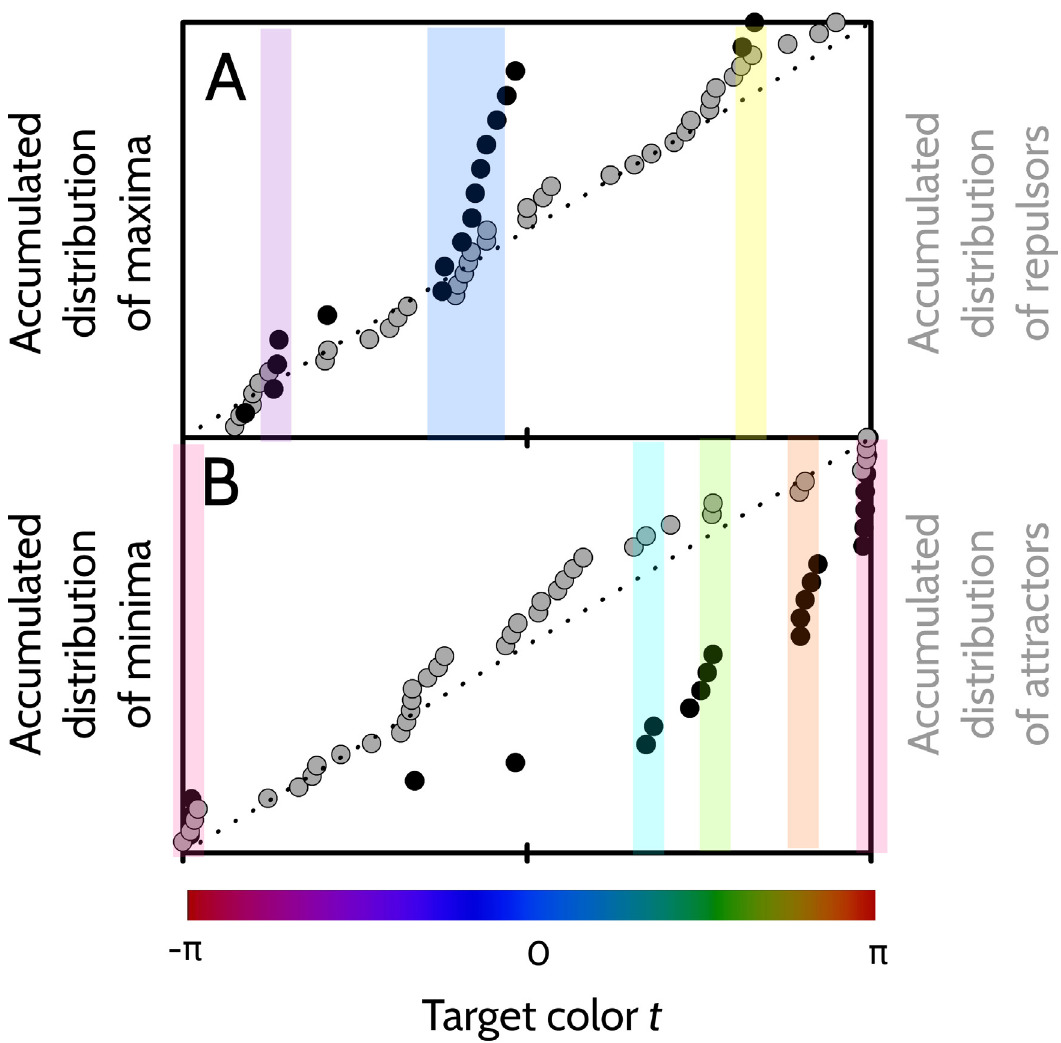
Fig 9. Relation between attractors, repulsors and Fisher information. Comparison of the locations of attractors and repulsors of Fig 6 with that of prominent maxima and minima in J ( t ) (Fig 7). A: Empirical cumulative distribution of repulsors (gray) and of prominent maxima of the Fisher information (black). Colored boxes highlight the regions of color space where both distributions appear to increase with slope larger than unity. B: Empirical cumulative distribution of attractors (gray) and of prominent minima of the Fisher information (black). Colored boxes: same as in A. In both panels, the vertical scale ranges between 0 and